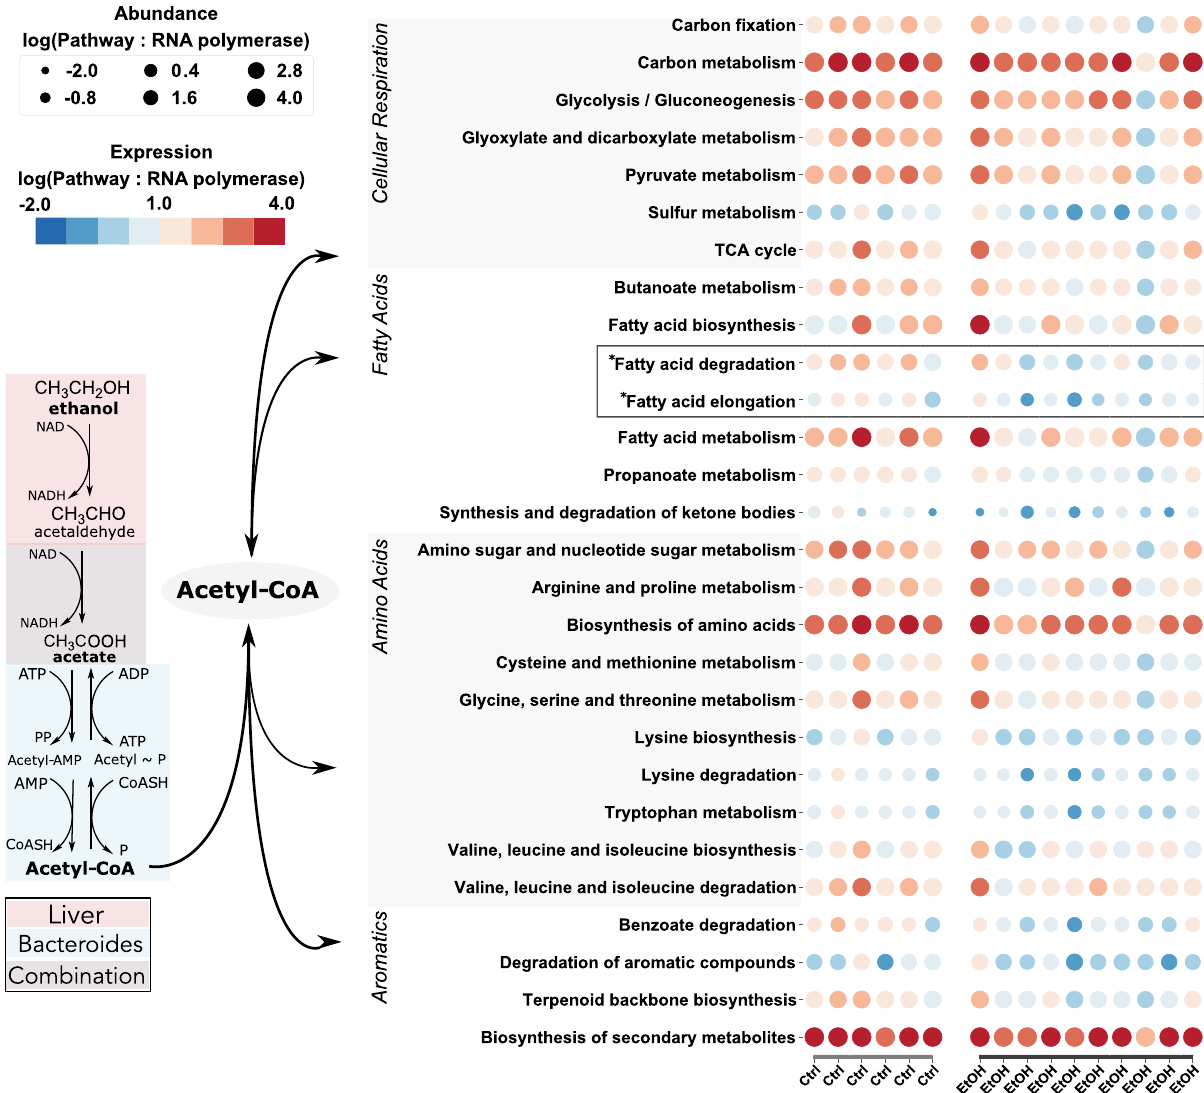
Fig. 3 Acetate and acetaldehyde converted from ethanol in the liver converted to acetyl-CoA by Bacteroides spp . are used in gluconeogenesis. (left) Pathways of ethanol to acetate (liver; red) and acetate/acetaldehyde conversion to acetyl-CoA (species of the Bacteroidetes phylum; blue). (right) Expression (color bar) and abundance (dot size) for pathways involved in the excretion or dissimilation of acetyl-CoA. The Gluconeogenesis pathway (bold) is upregulated in alcohol treatment compared to controls. Source data are provided as a Source Data